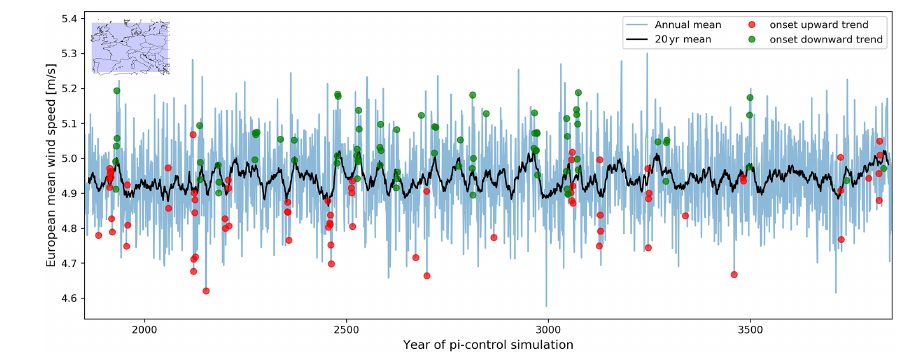
Figure 6. Wind speed time series averaged over Europe under pre-industrial control conditions (pi-control). Blue (black) lines denotes annual (20-year) means and red (green) dots mark onset years of statistically significant upward (downward) trends over 20-year periods. Dots of the same color can occur in consecutive years if the trends persist over more than 20 years.